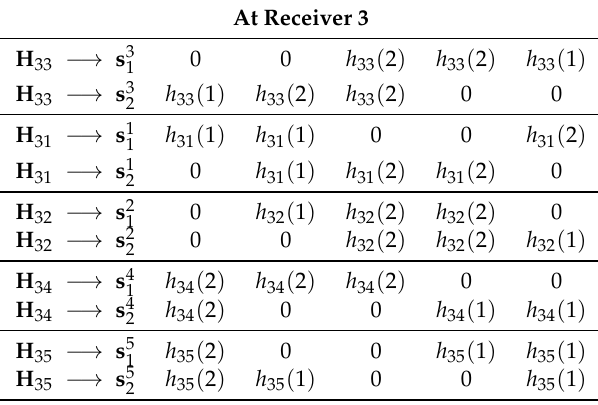
Table 2. Antenna switching pattern for receiver 2.